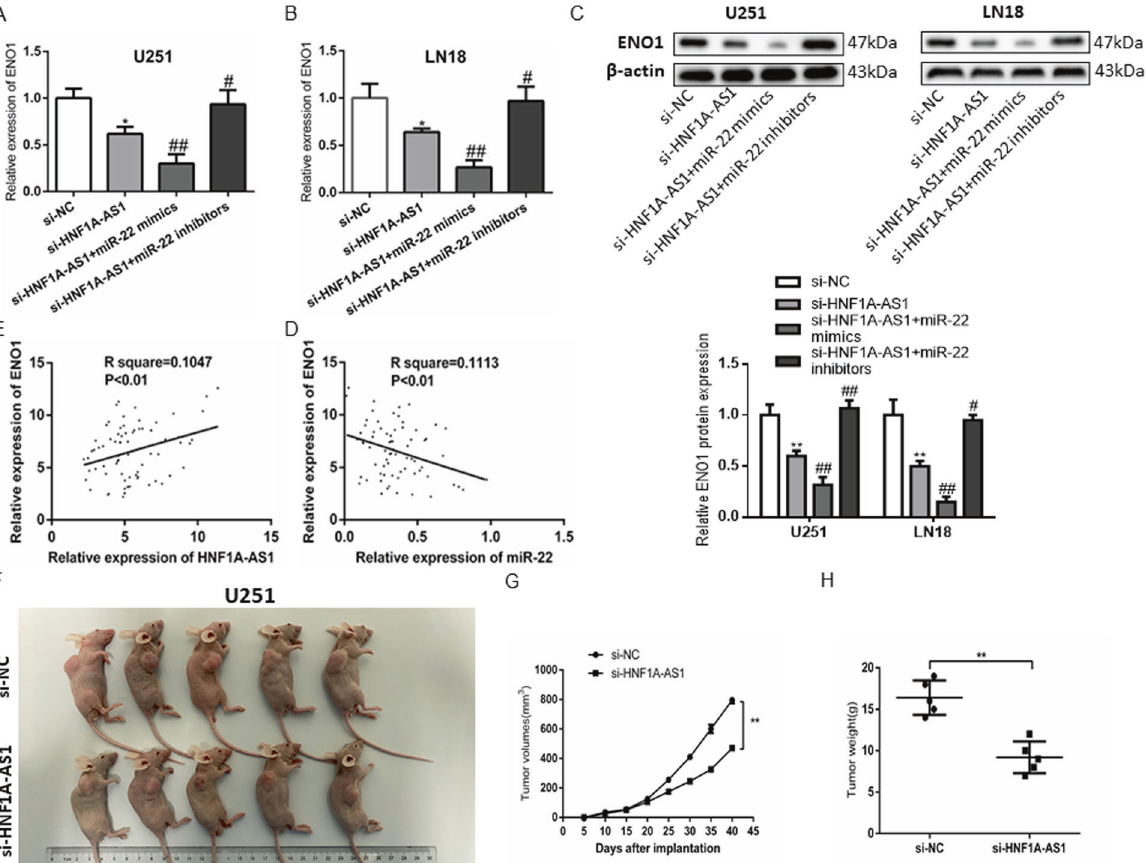
Fig. 8 HNF1A-AS1 strengthen ENO1 expression by inhibiting miR-22 in GBM, and promotes tumor growth in vivo. A – C RT-QPCR and Western blot assays were performed to detect the mRNA and protein levels of ENO1 after cells transfected with si-HNF1A-AS1 and miR-22 mimics or miR-22 inhibitors. * P < 0.05, ** P < 0.01 vs. si-NC group; # P < 0.05, ## P < 0.01 vs. si-HNF1A-AS1 group. Data are presented as mean ± SD from three independent experiments. D Pearson ’ s correlation analysis of the relationship between ENO1 expression and HNF1A-AS1 expression. E Pearson ’ s correlation analysis of the relationship between ENO1 expression and miR-22 expression. F U251 cells were stably transfected with si-NC or si-HNF1A-AS1, which were injected subcutaneously into nude mice, respectively. G Tumor volumes were calculated every 5 days after injection. ** P < 0.01 vs. si-NC group. H Tumor weight were signi fi cantly decreased in the si-HNF1A-AS1 group. ** P < 0.01 vs. si-NC